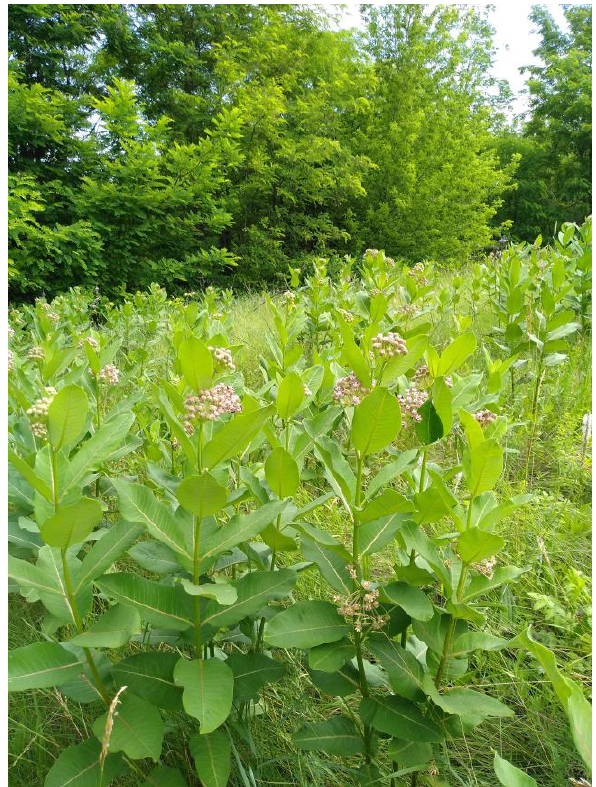
Fig. 8. Asclepias syriaca L. in Forest